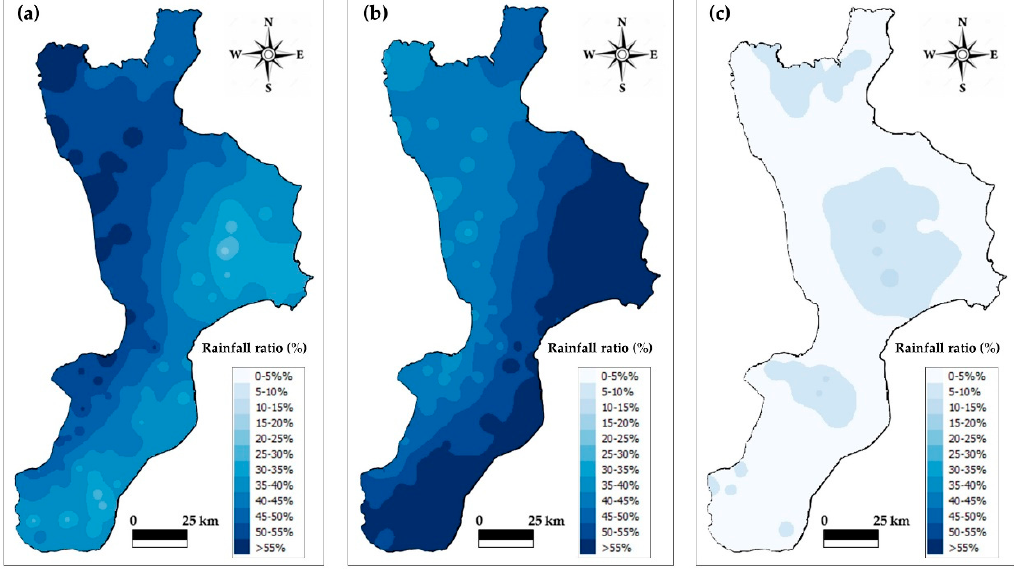
Figure 8. Ratio between cluster rainfall and total rainfall of all events for HSS ( a ), VHSS ( b ) and CSLE ( c ).